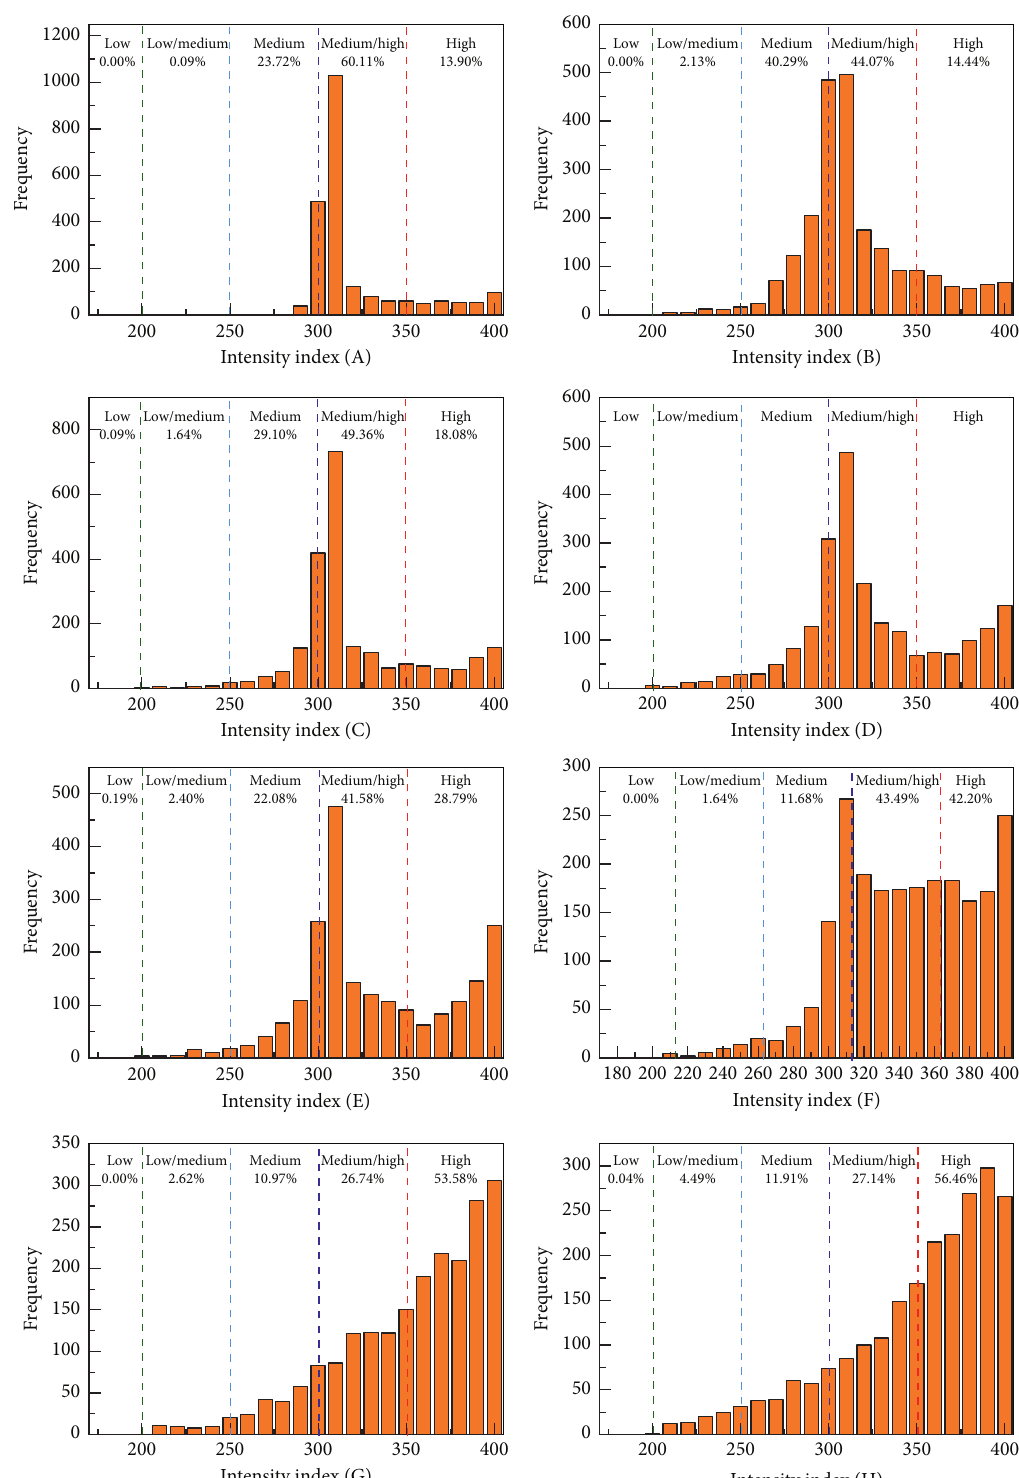
Figure 8: Histograms of frequency counts of land use intensities in the central urban area of the study area from 1984 to